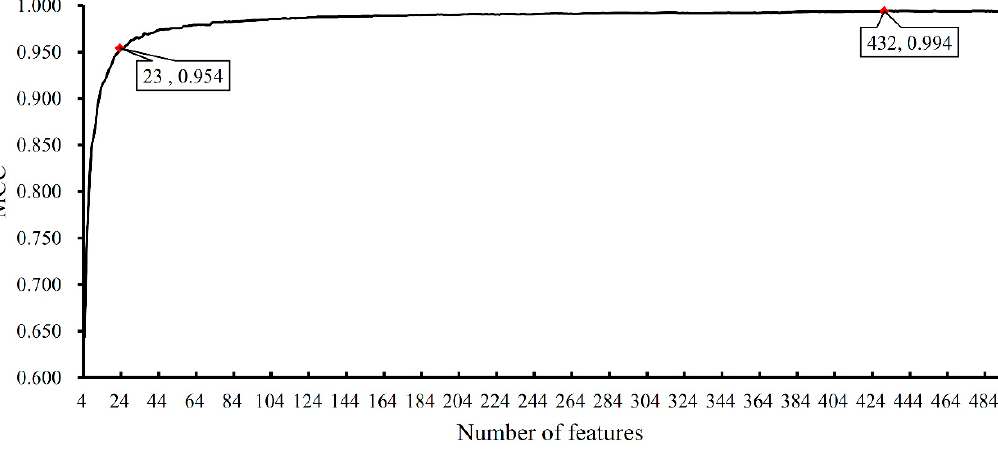
Figure 1. The incremental feature selection (IFS) curve illustrating the performance of the classification models using different numbers of features. Red diamonds represent the performance when the top 23 genes and 432 features were used for building the classification models.